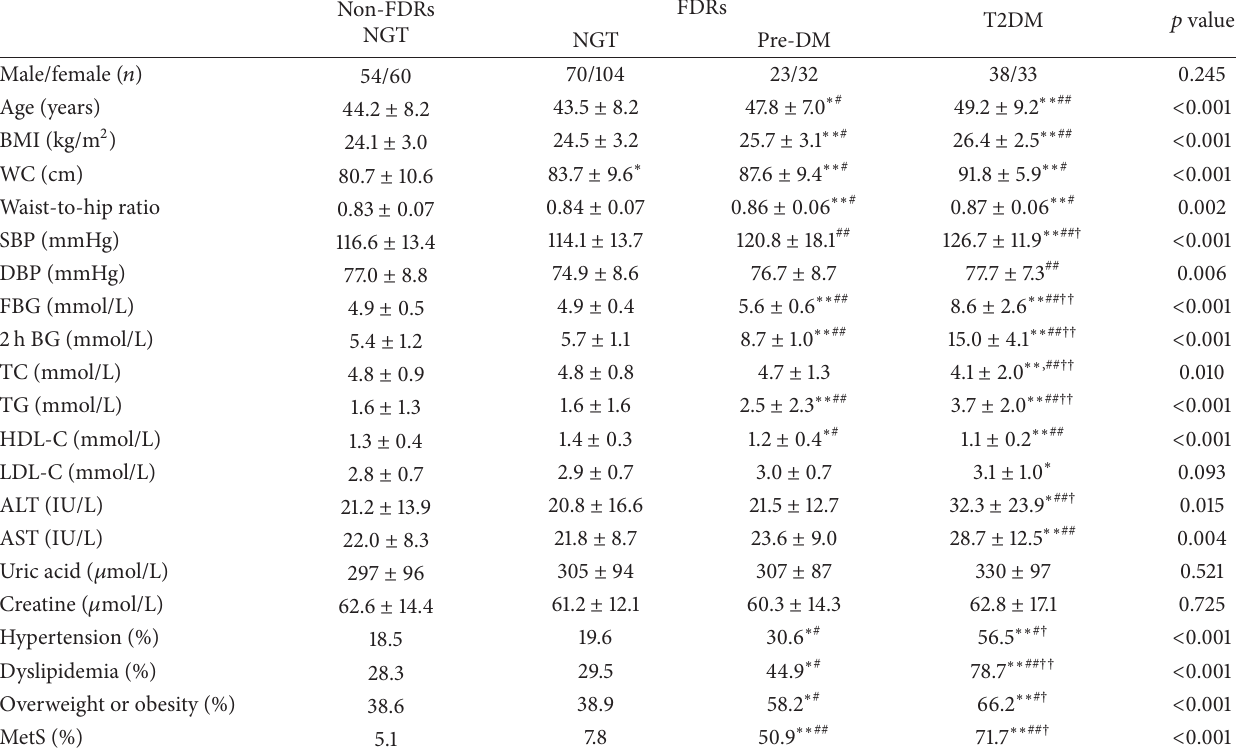
Table 1: The basic clinical and biochemical characteristics of the study